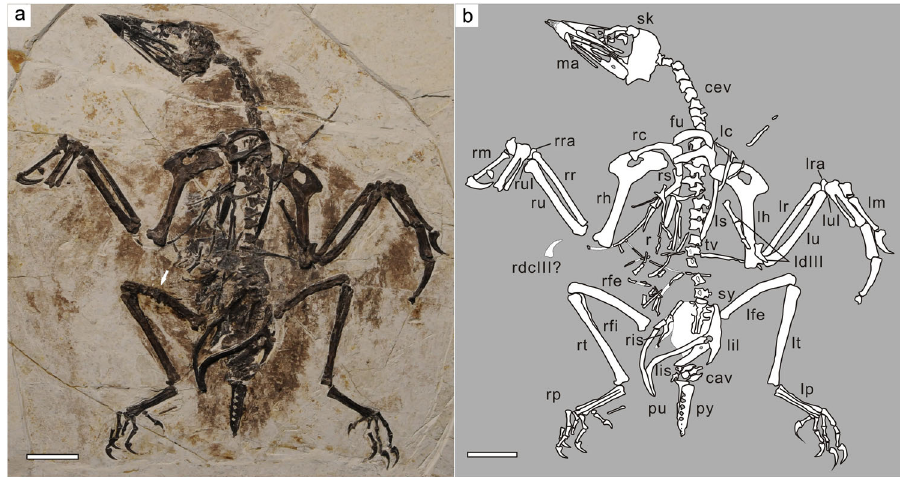
Fig. 1 Confuciusornis shifan holotype (PMoL-AB00178). a Photograph. b Schematic line drawing. cav caudal vertebra, cev cervical vertebra, fu furcula, ga gastralia, lc left coracoid, ldIII left manual digit III, lfe left femur, lh left humerus, lil left ilium, lis left ischium, lm left manus, lp left pes, lra left radiale, lr left radius, ls left scapula, lt left tibiotarsus, lu left ulna, lul left ulnare, ma mandible, pu pubis, py pygostyle, r rib, rc right coracoid, rdcIII claw of right manual digit III, rfe right femur, r fi right fi bula, rh right humerus, ris right ischium, rm right manus, rp right pes, rra right radiale, rr right radius, rs right scapula, rt right tibiotarsus, ru right ulna, rul right ulnare, sk skull, sy synsacrum, tv thoracic vertebra. Arrow indicates the position from which the histological section of the right femur was taken. Scale bars: 2